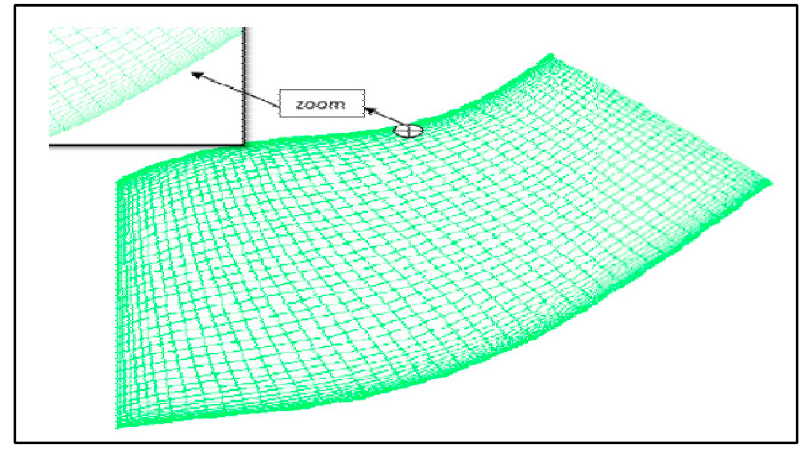
Figure 4. The mesh refinement near the wall [42].